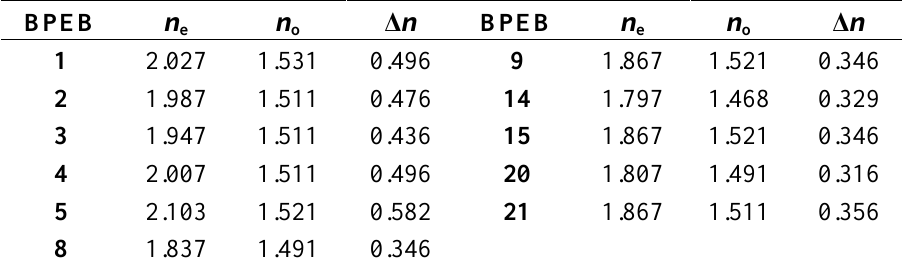
Table 2. Δ n values of BPEBs.